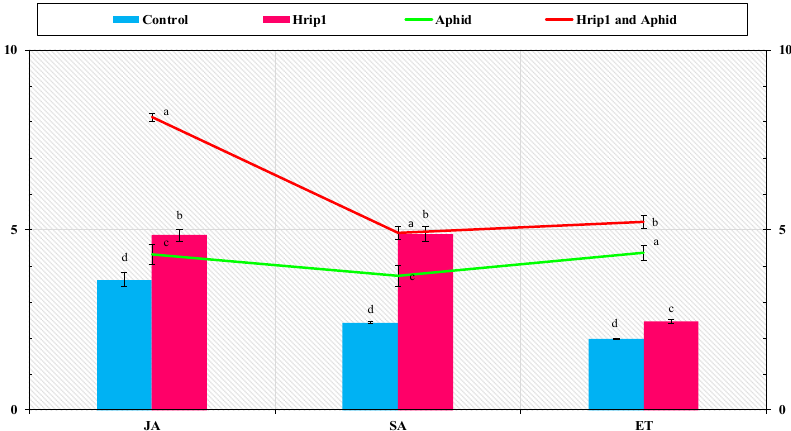
Figure 6. Phaseolus vulgaris seedling JA, SA, and ET levels (mean ± SD). An additional day after spraying, Hrip1 data were collected, and aphids were infected in both treatments. The LSD, ANOVA, and Leven’s test were used to compare data in 8.1 Statistix, with lower-case letters indi- cating significant JA, SA, or ET treatment differences. ( p = 0.05). 3.5. Defense-Related Gene Expression Fold Change Hrip1 boosted defenses in P. vulgaris seedlings. Hrip1 treatment slightly upregulated all JA and SA pathway test genes (Figures 7 and 8). The Log2 of all test genes was calcu- lated using fold-change expression values, indicating that transcription triggered aphid confrontation.